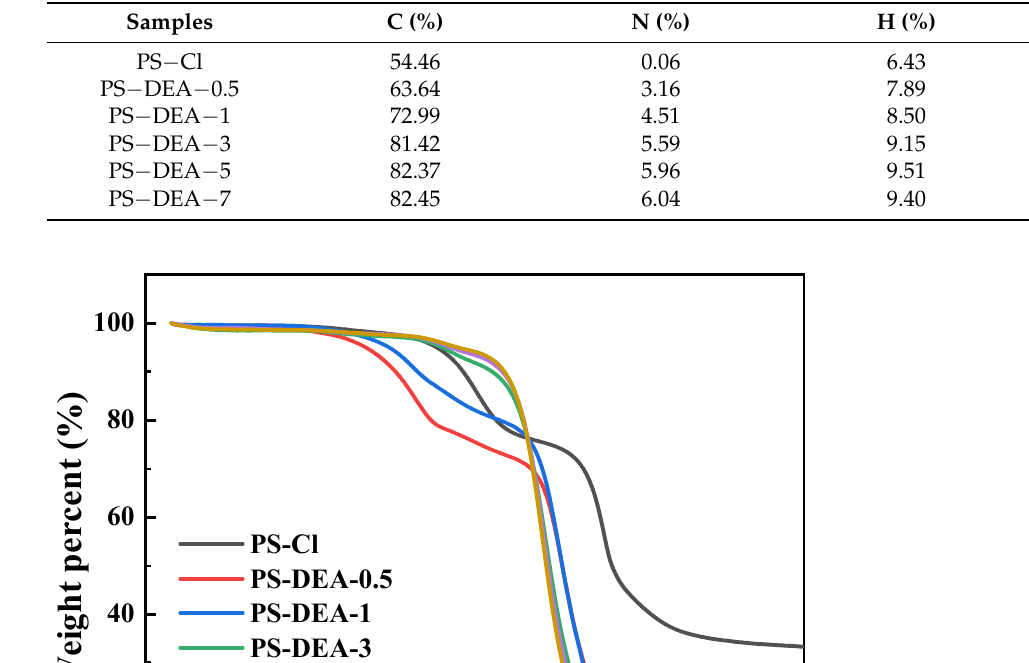
Figure 1. FT − IR spectra of PS − DEA − x. Table 1. Element contents in different PS − DEA − x.